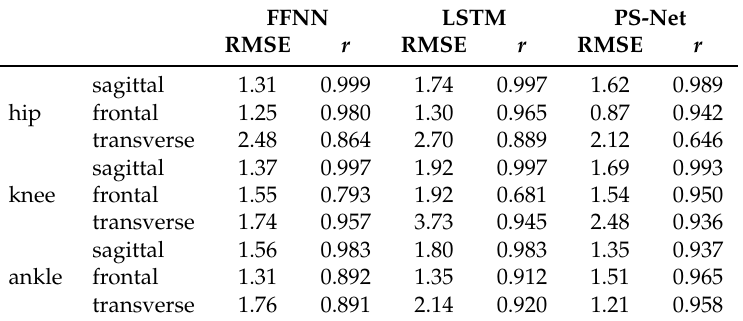
Table 4. Results of the RMSE and the correlation coefficient r achieved in